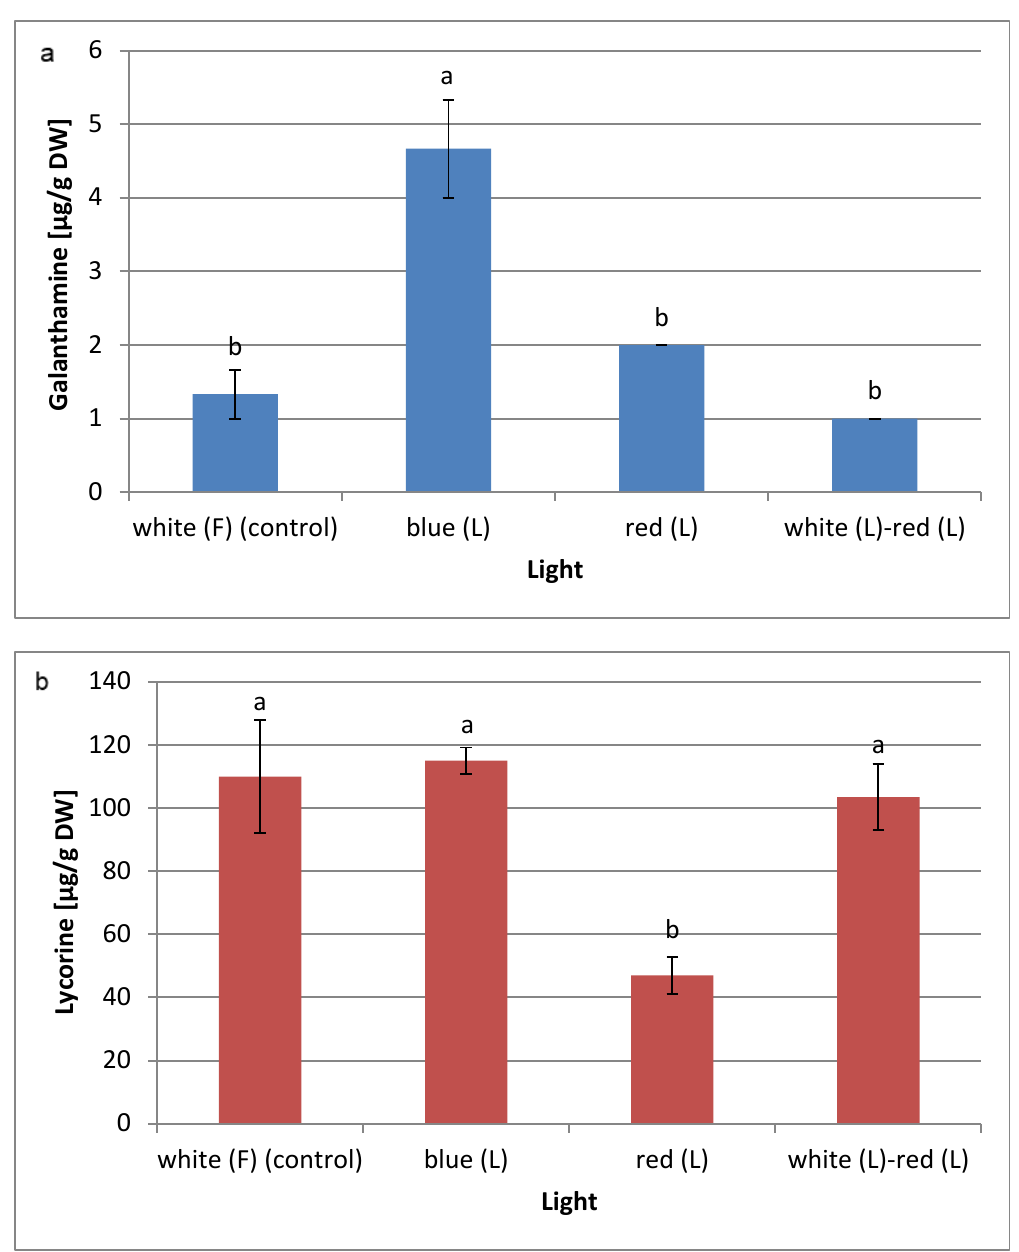
Figure 5. Effect of different light conditions on ( a ) galanthamine and ( b ) lycorine contents determined by LC-MS in L. aestivum in vitro plants. The results are means of 3 replicates ( n = 3). Error bars represent ± SD. Different letters indicate a significance difference at p < 0.05 according to ANOVA and Duncan’s test. F: fluorescence, L: LED light, DW: dry weight.